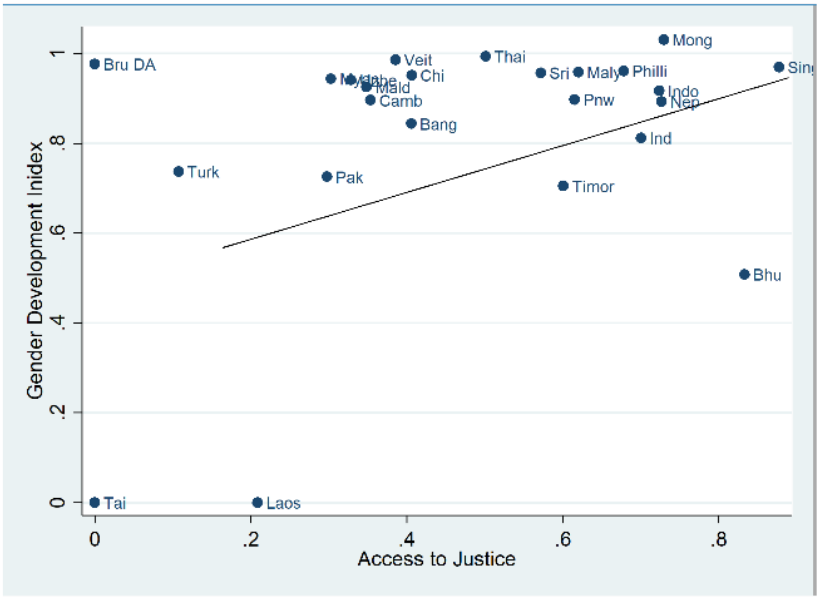
Figure 2. Gender Development Index and Access to Justice.